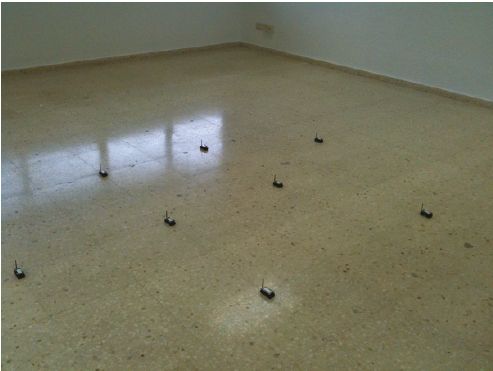
Figure 4: Arrangement of nodes in the localization